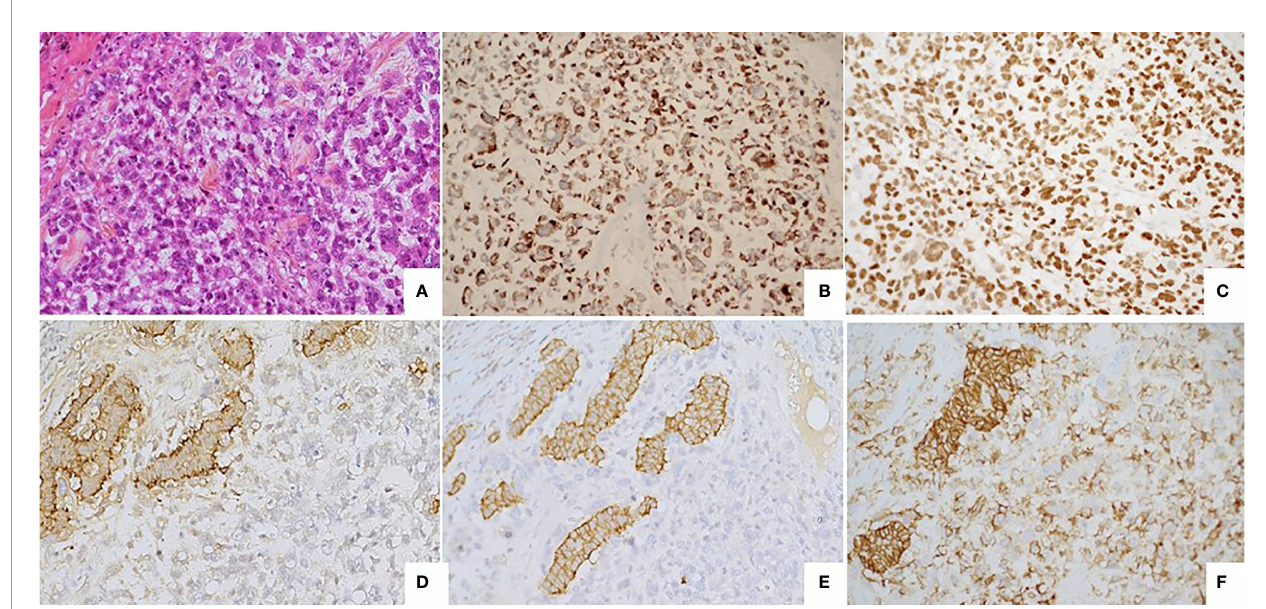
FIGURE 3 | Poorly differentiated tumor (A) Large cell neuroendocrine carcinoma composed by large cells with high mitotic index (> 20 mitoses/2mm 2 ). HES, x20. (B) Immunostaining CKAE1/AE3, monoclonal antibody, clone AE1/AE3/PCK26, Ventana, x20. (C) Immunostaining KI67 : high nuclear expression (> 70%) monoclonal antibody, clone MIB1, Agilent Dako, x20. (D) Immunostaining Chromogranin A, monoclonal antibody, clone LK2H10, Ventana, X20. (E) Immunostaining Synaptophysin, monoclonal antibody, clone SP11, Ventana, X20. (F) Immunostaining CD56, monoclonal antibody, clone MRQ-42, Ventana/Cell marque, X20.